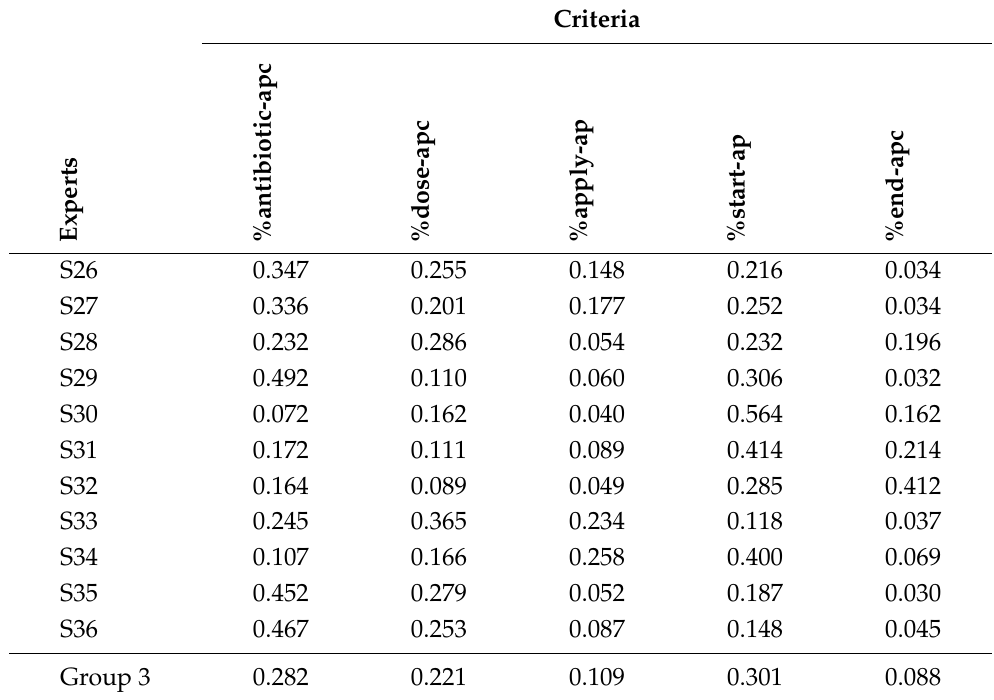
Table 11. APC criteria weights based on the individual comparison matrices, and the group criteria weights. (S1 to S9 indicate experts participating in the AHP